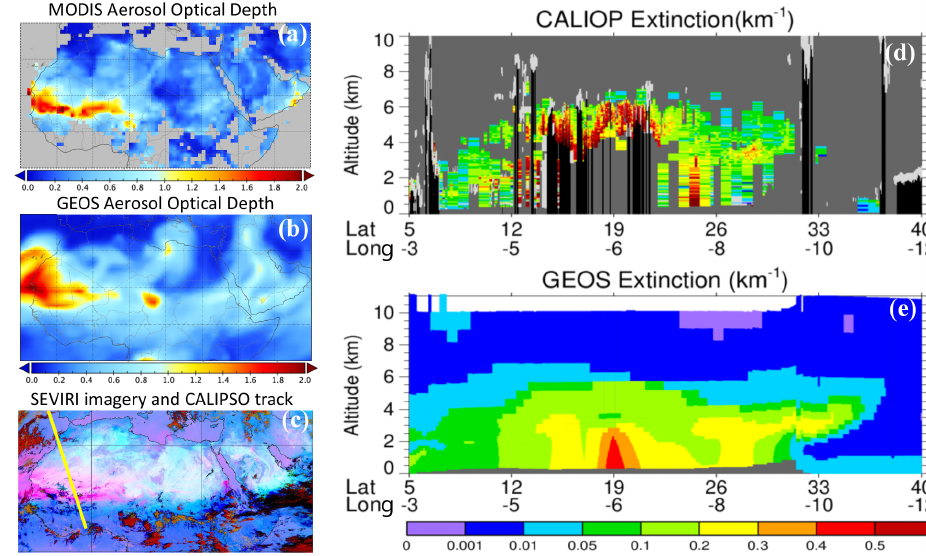
Figure 14. Same as Fig. 13 except for 15 June